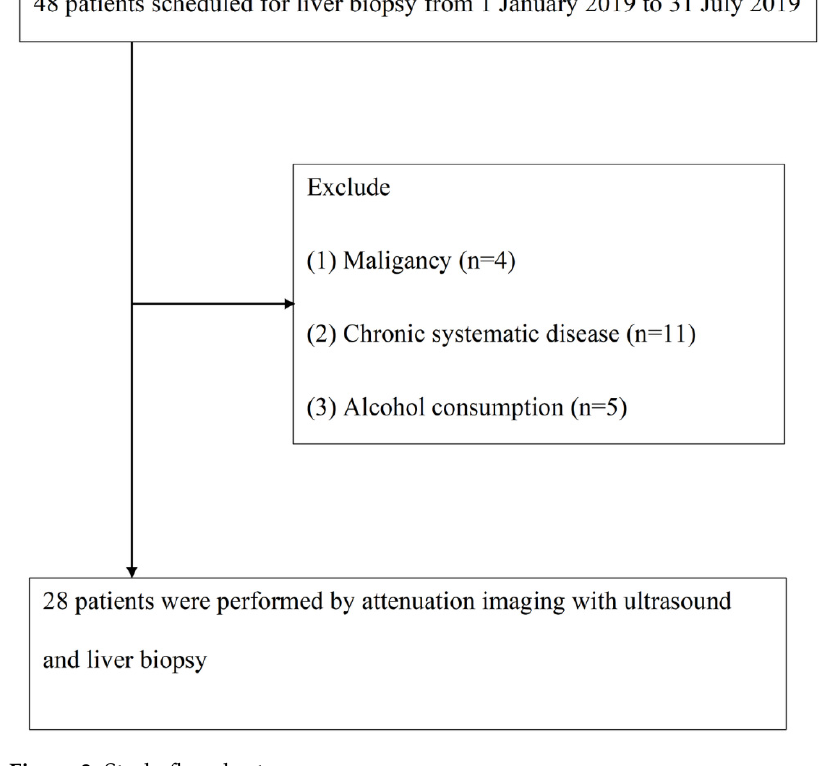
Figure 3. Study flowchart.